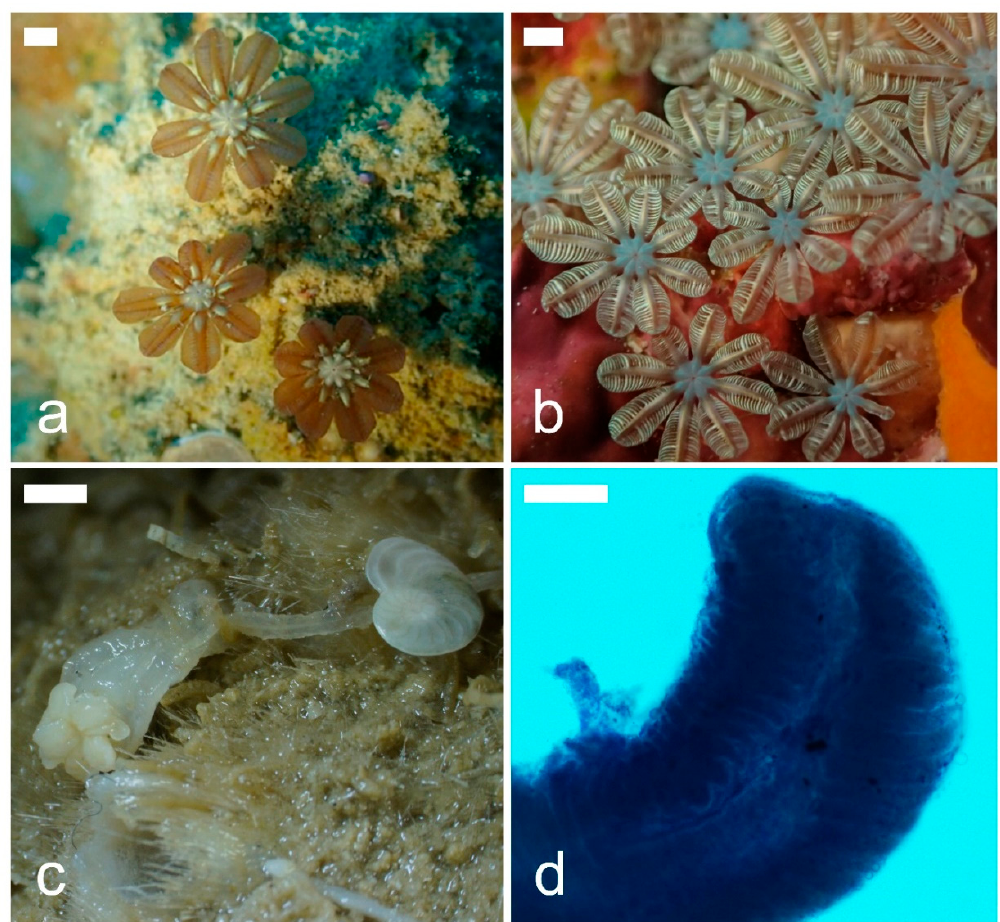
Figure 2. Photographs of Hadaka nudidomus gen. nov. et sp. nov.: ( a ) in situ holotype NSMT-Co 1681, scale bar approximately 1 mm; ( b ) in situ paratype NSMT-Co 1682, scale bar approximately 1 mm; ( c ) holotype in ethanol, scalebar 1 mm; ( d ) holotype in methylene blue staining, scale bar 0.1 mm.